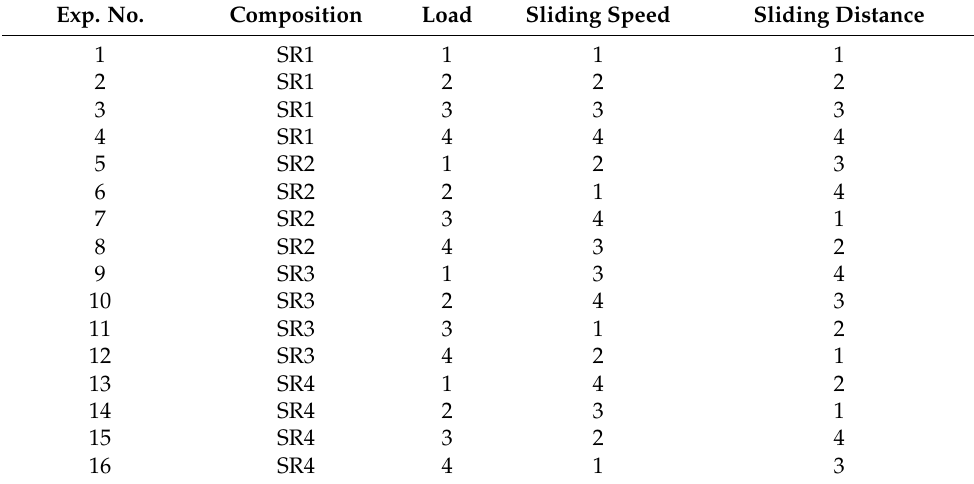
Table 4. Taguchi L 16 orthogonal array for the design of tribological experiments. Exp. No. Composition Load Sliding